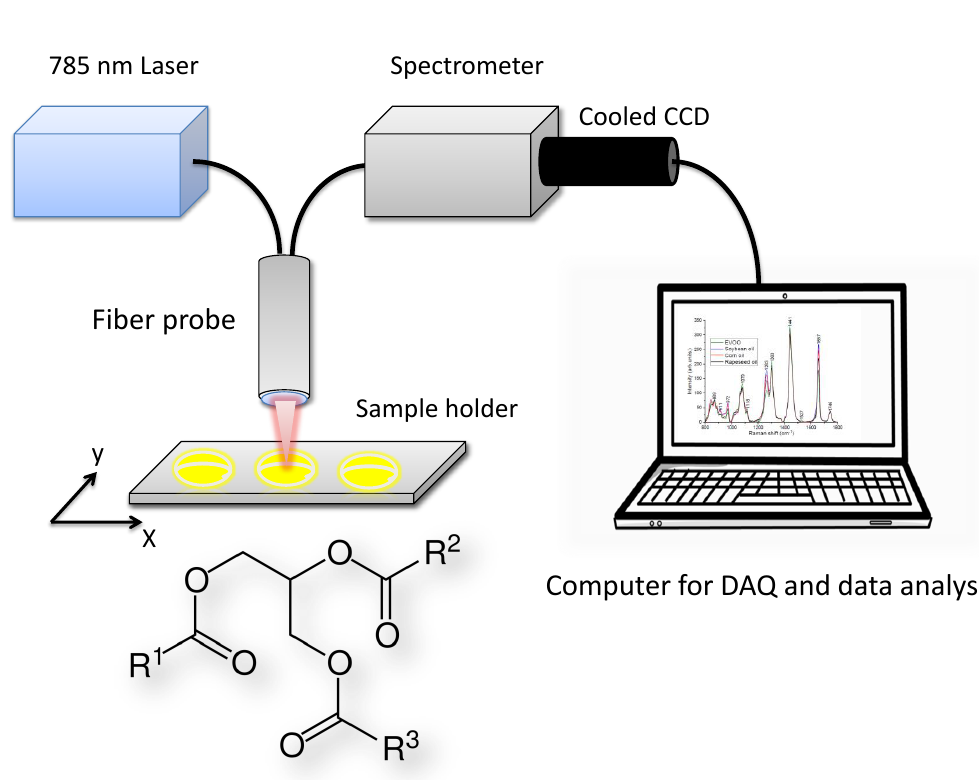
Figure 1. Fiber optic Raman spectroscopy set up. The general chemical structure of extra virgin olive oil (EVOO), where R 1 , R 2 and R 3 are alkyl groups (approx. 20%) or alkenyl groups (approx. 80%).